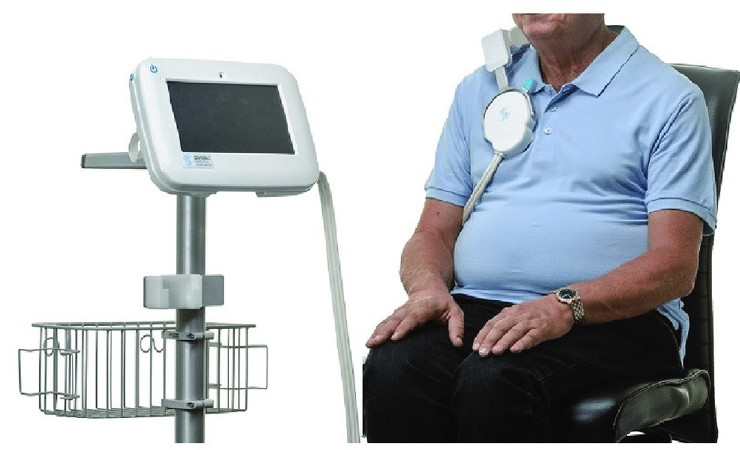
Figure 1. A ReDS system, which consists of a monitor and a sensor unit.